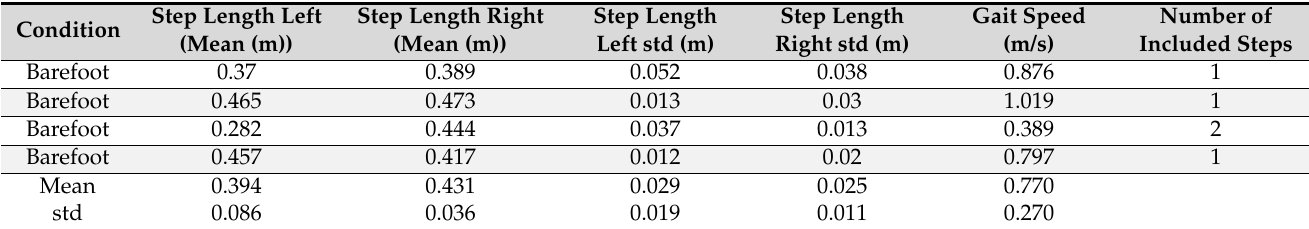
Table 1. Mean and standard deviation (std) of gait parameters in the training